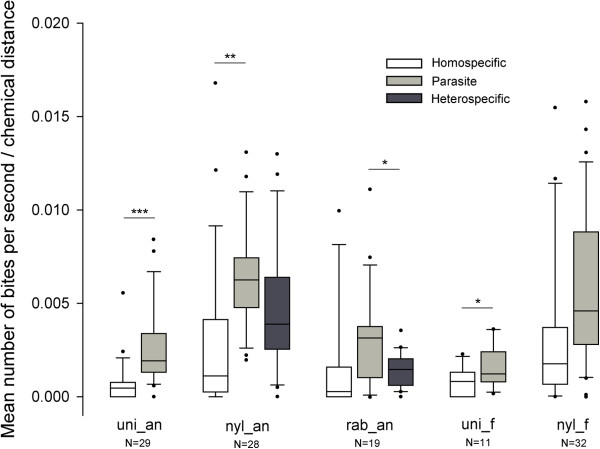
Box-and-whisker plots for bite rates inflicted in recipient colonies scaled by chemical distance. We scaled the mean bite rates by chemical distance between the intruders and the recipient colonies from populations of M. ravouxi, T. unifasciatus, T. nylanderi and T. rabaudi from Anduze (myr_an, uni_an, nyl_an and rab_an respectively), and of T. unifasciatus and T. nylanderi from Fontainebleau (uni_f and nyl_f respectively). Box plots show the median and 25-75% percentiles. Whiskers show all data excluding outliers outliers outside the 10th and 90th percentiles (circles). Figures under bars indicate number of tests. * P < 0.05, ** P < 0.01, *** P < 0.001.